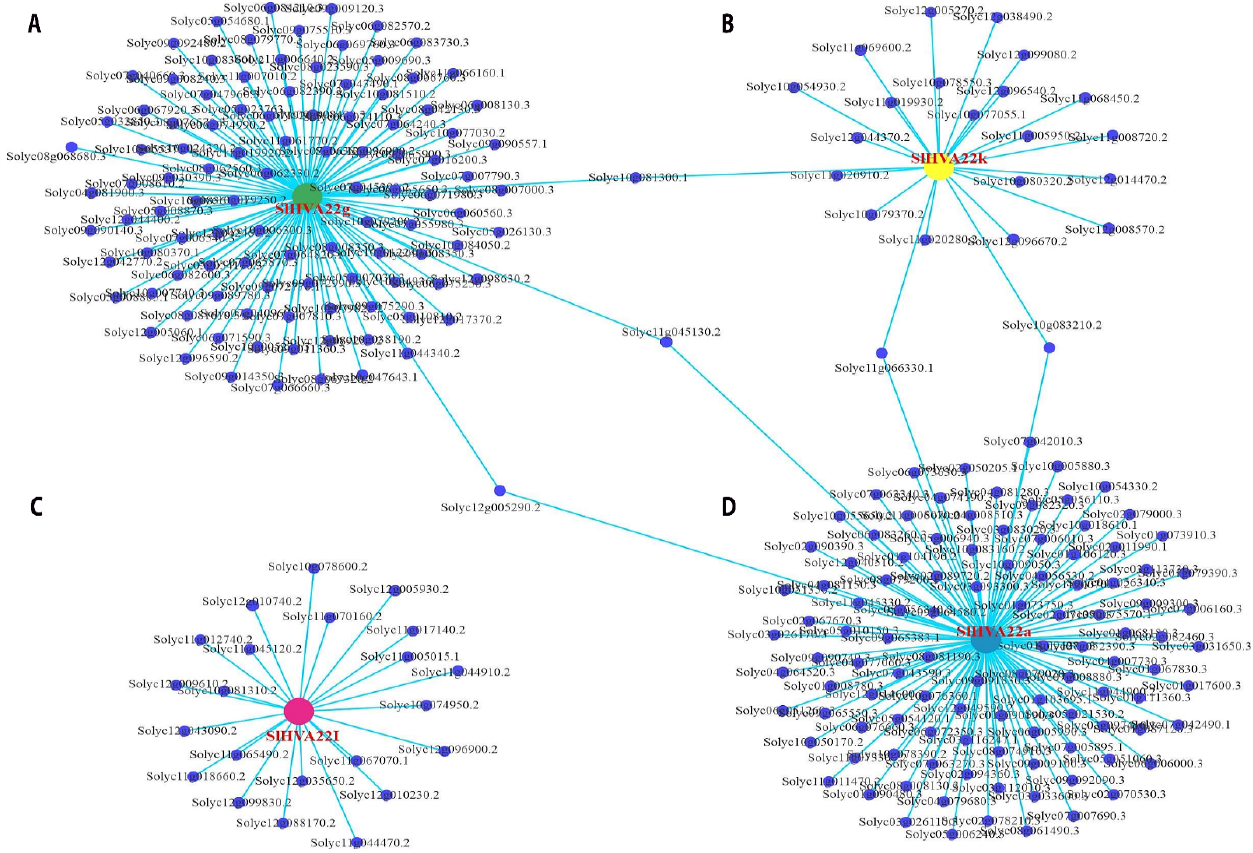
Figure 6. Weighted gene co-expression network analysis (WGCNA) of SlHVA22 genes. A–D: the co-expressed genes in the network of SHVA22g ( A ), SHVA22k ( B ), SlHVA22l ( C ), and SlHVA22a ( D ). The SlHVA22 genes are marked in red.